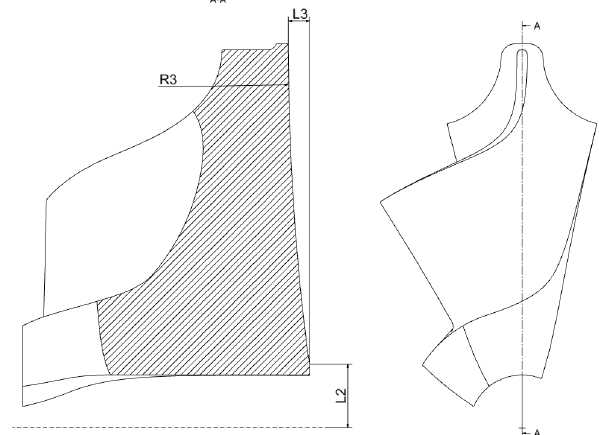
Figure 22: Variable parameters used during optimisation using method 3